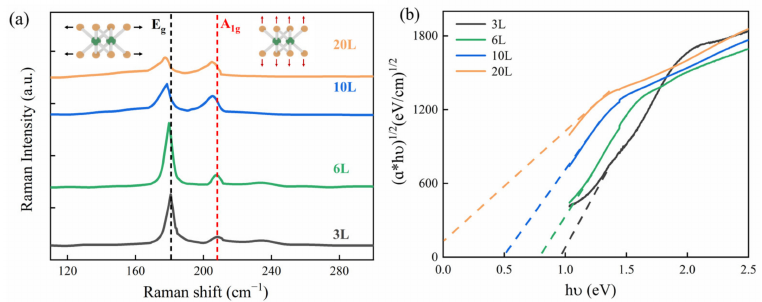
Figure 1. ( a ) Raman spectra of PtSe 2 films with different layers; in the illustration, the yellow circle is Se atom, the green circle is Pt atom, and the arrows indicate the direction of atoms’ motion. ( b ) Relationship between absorption coefficient and band gap of PtSe 2 films with different